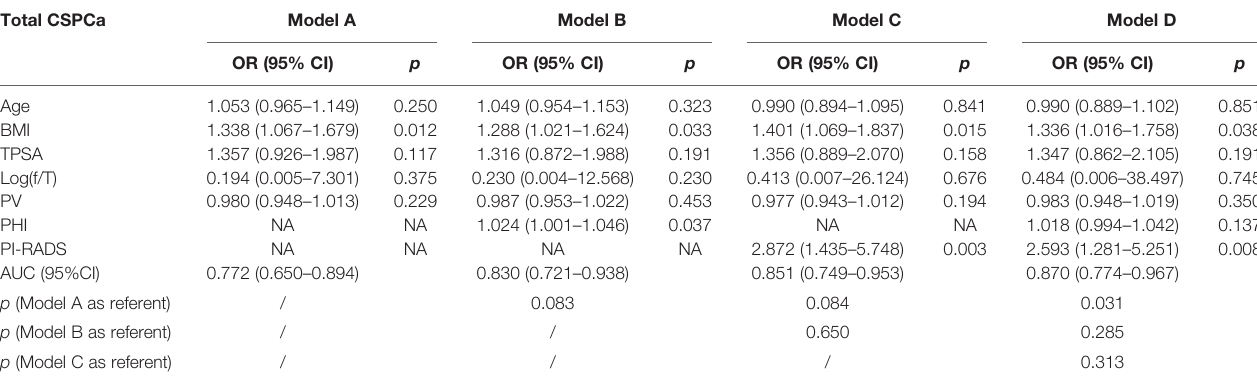
TABLE 3B | Multivariable analysis of the predictive value of the different models in the diagnosis of CSPCa in the PSA 4 – 10